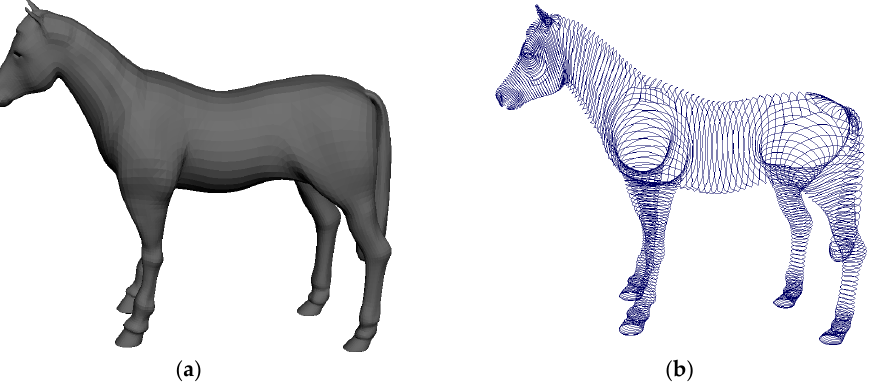
Figure 5. Undeformed horse model and extracted curves. ( a ) Polygon horse model, ( b ) extracted curves.